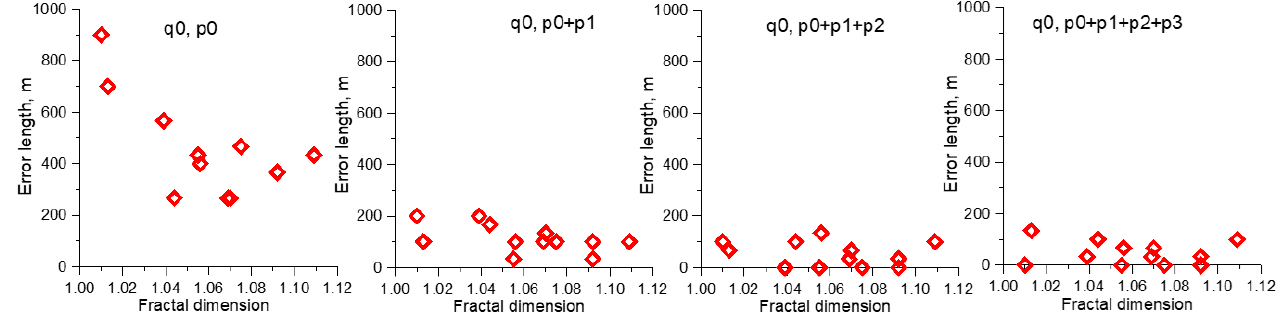
Figure 13. The average length of the error in relation to the fractal dimension and the number of monitoring sensors